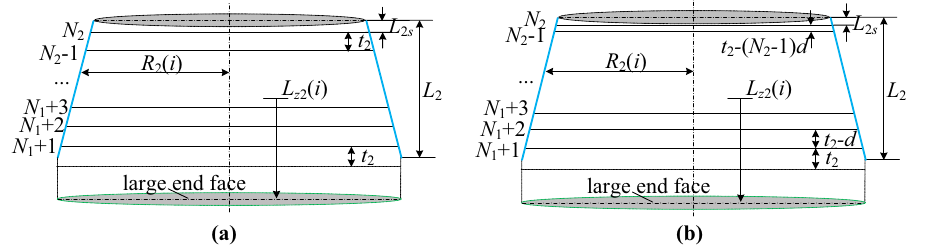
Figure 4. The design sketch of the conical section: ( a ) equidistance; ( b )